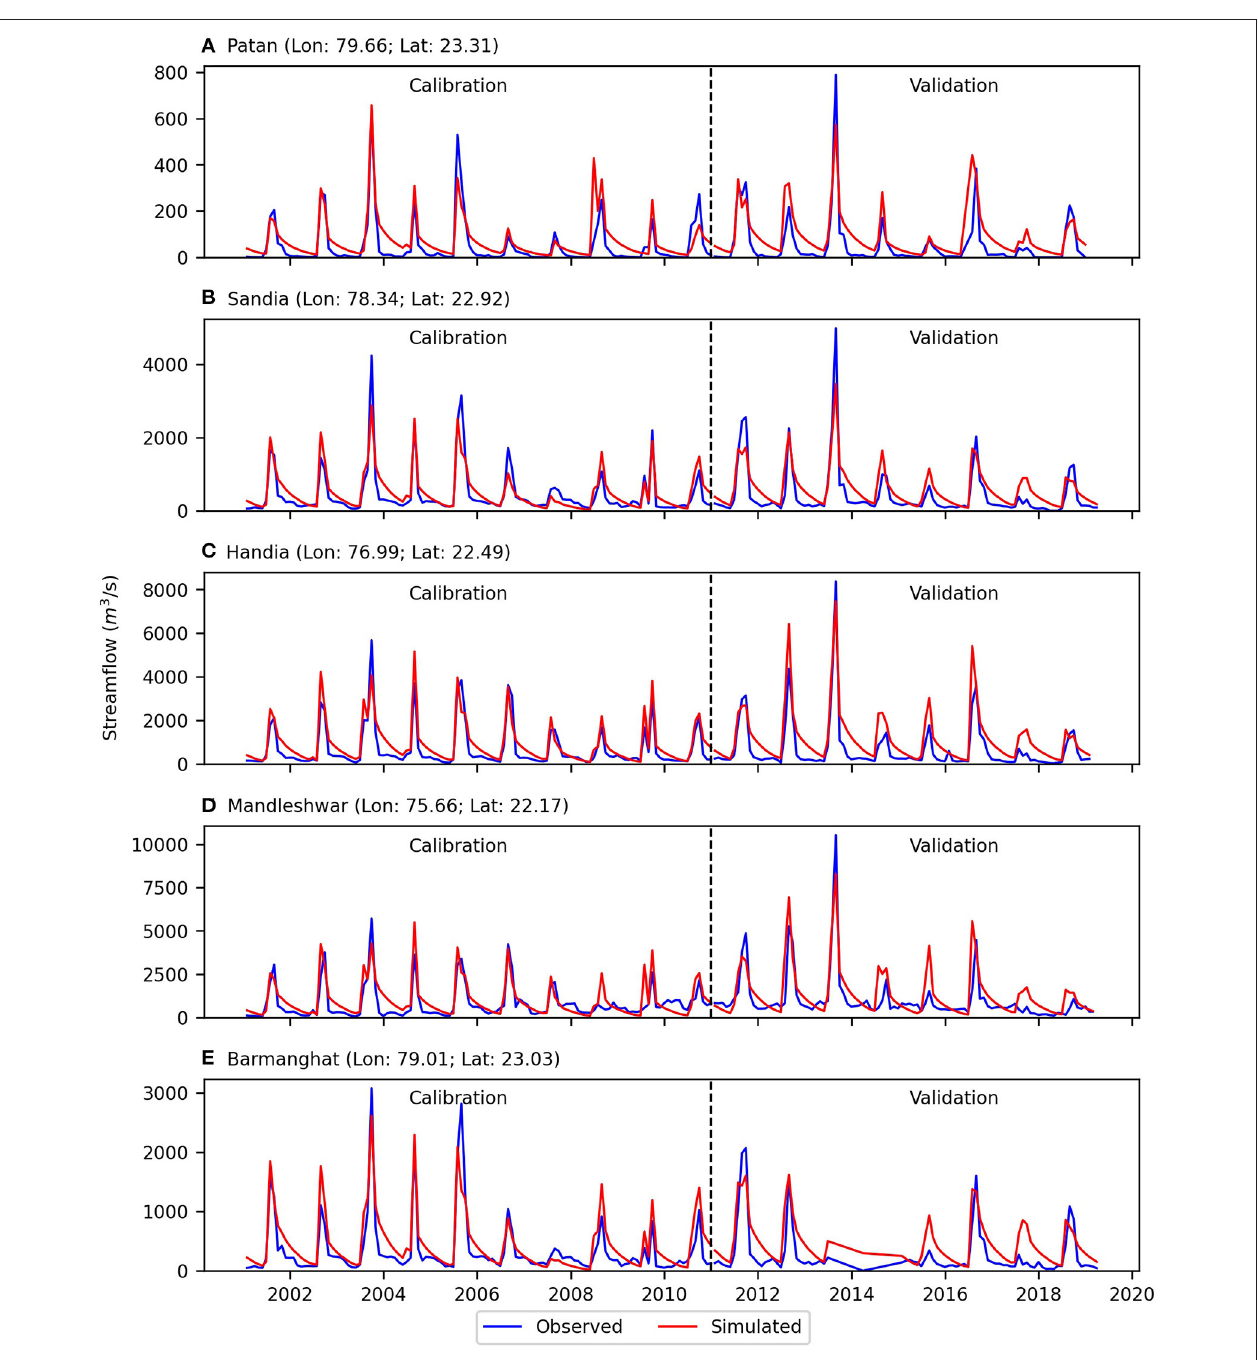
FIGURE 3 | (A–E) : Time series of streamflow comparison between simulated and observed (CWC) streamflow for calibration and validation phase. Calibration was performed for 2001–2010 and validation was performed for 2011–2019. Black dotted line represents the end of calibration period and start of validation period for